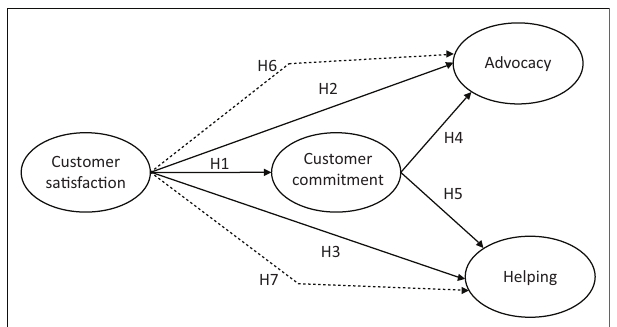
FIGURE 1: Conceptual